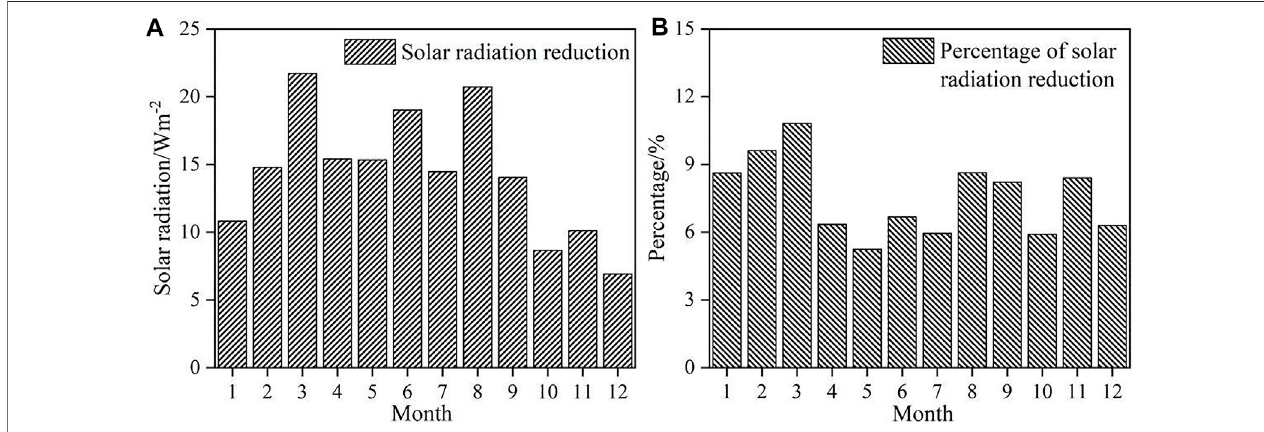
FIGURE 2 | Reduction (A) and percentage of reduction (B) of simulated ground solar radiation caused by the DRE in 2021.